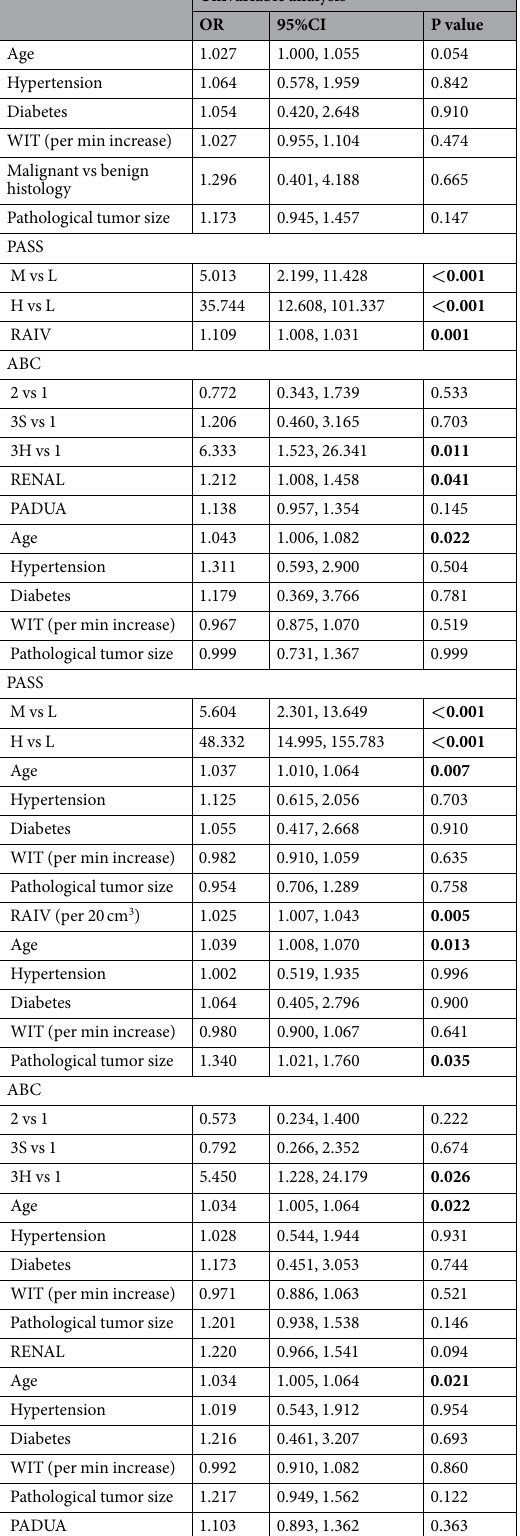
Table 3. Univariable and multivariable logistic regression for perioperative factors associated with postoperative ePD10 in discovery